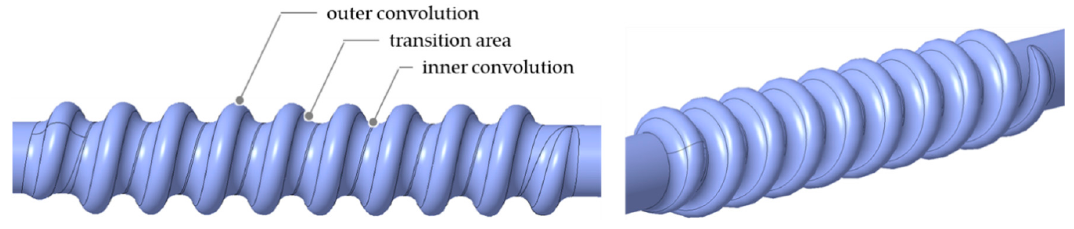
Figure 2. Design of helically shaped demonstrator part.